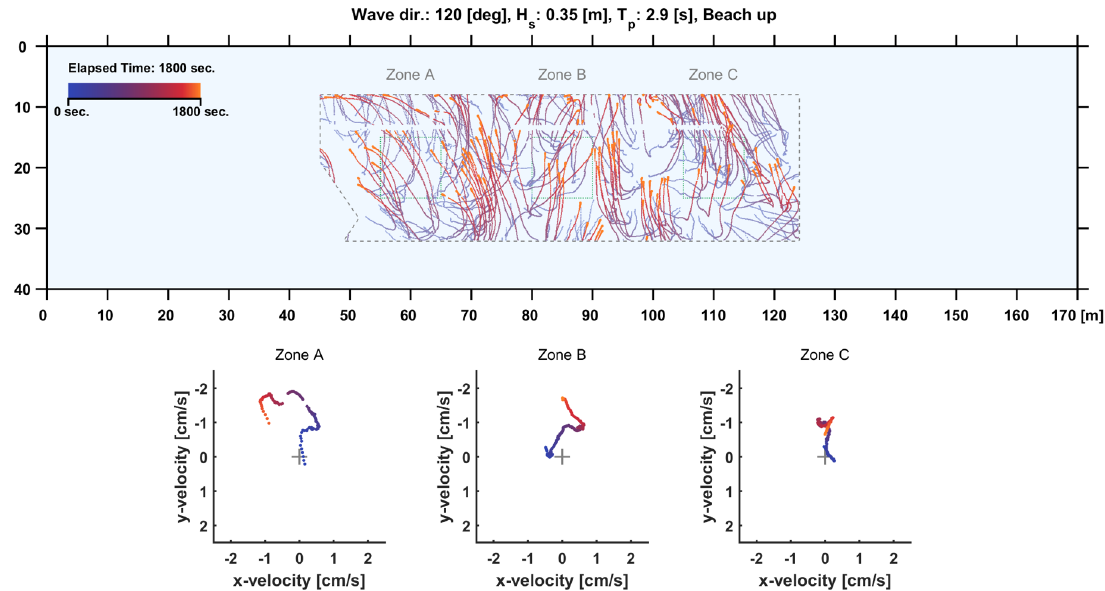
Figure 2. Example of a measured current pattern MARIN’s Seakeeping and Manoeuvring Basin, following trackers in the 5–35 min after 30 min generation of an oblique wave (heading 120 deg so from the bottom right, long beach up)—the figure similar to those published in [27], but for a different wave